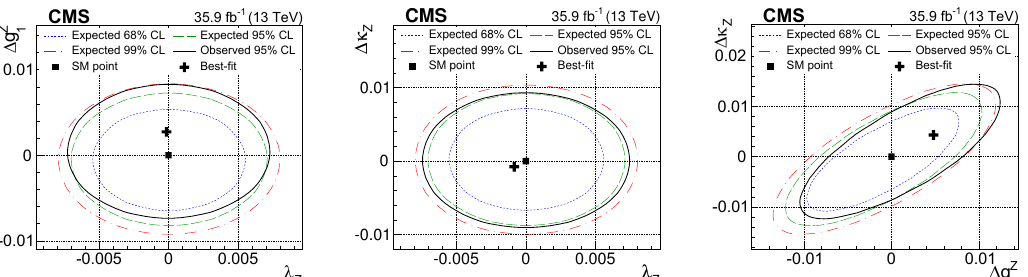
Figure 6 . Two-dimensional limits on the aTGC parameters in the LEP parametrization, for the combinations (cid:21) {(cid:1) g Z (left), (cid:21) {(cid:1) (cid:20) (centre), and (cid:1) g Z {(cid:1) (cid:20) (right). Contours for the expected Z Z Z Z 1 1 95% CL are shown in dashed green, with the 68 and 99% CL contours shown in dotted blue and dot-dashed red, respectively. Contours for the observed 95% CL are shown in solid black. The black square markers represent the SM expectation, while the black crosses show the observed best-(cid:12)t